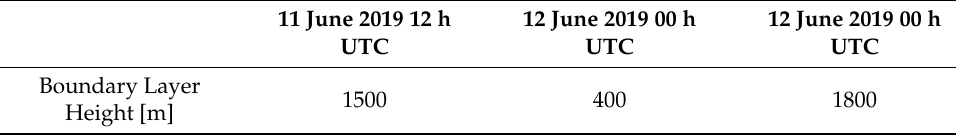
Table 5. The boundary layer height estimation for the three radio soundings.